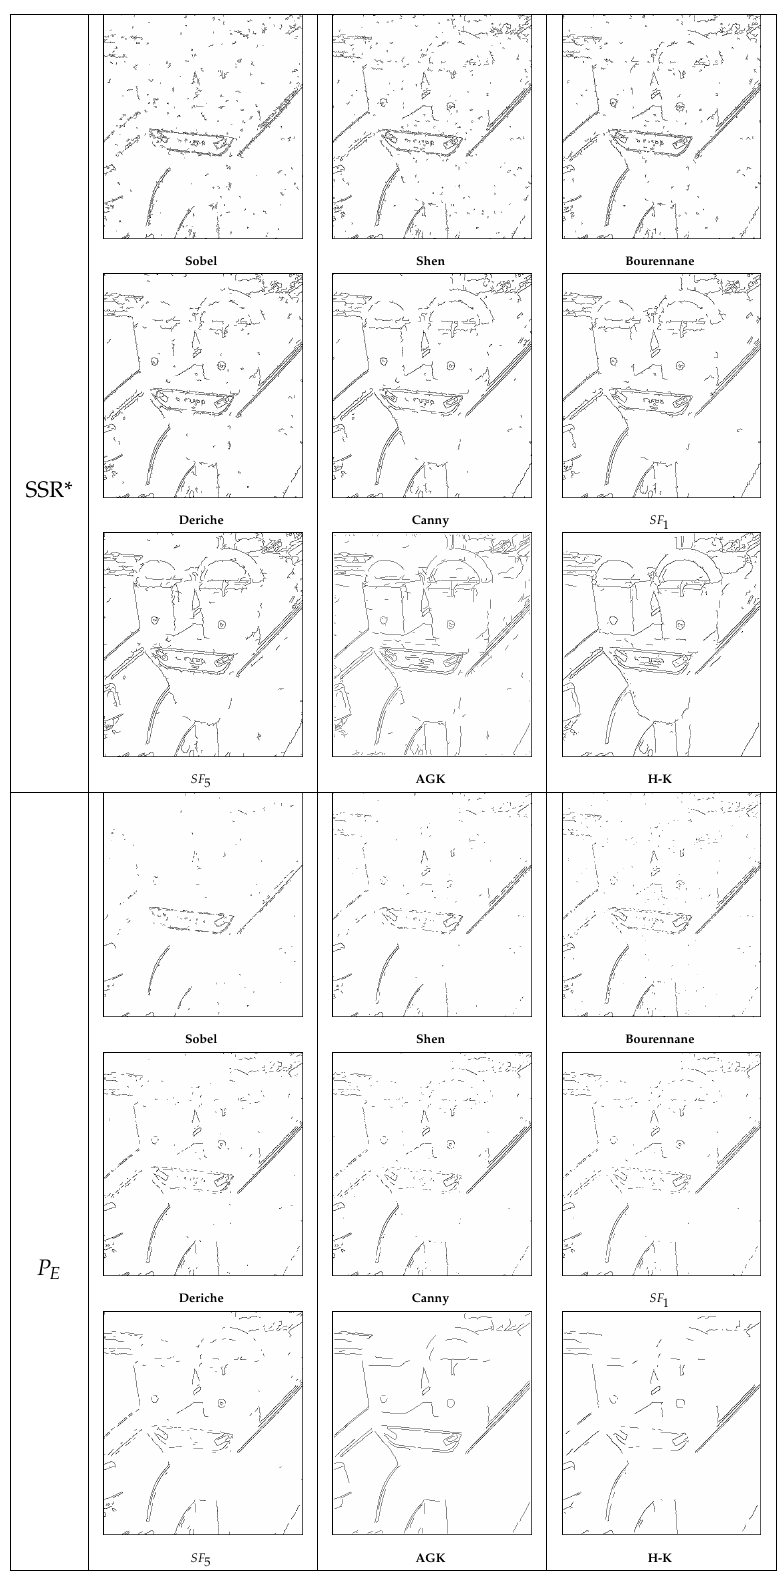
Figure 35. Ideal segmentations for several edge detectors on image parkingmeter, PSNR = 14